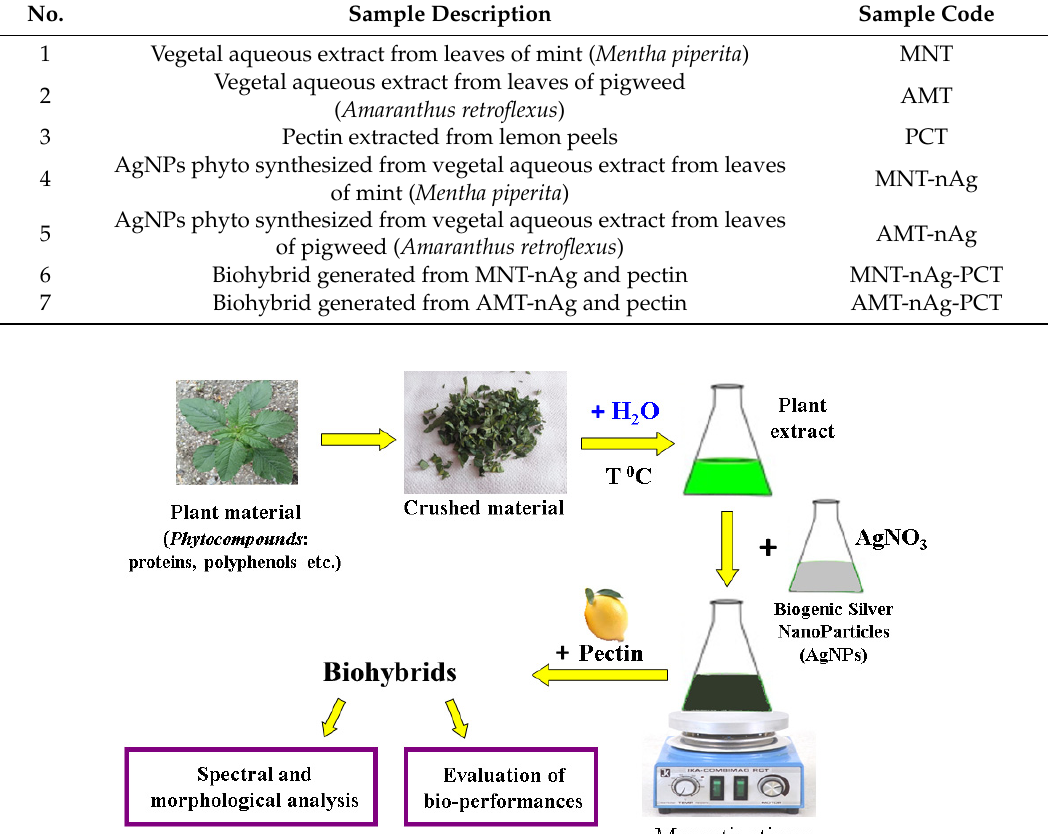
Figure 1. Schematic representation of phyto-generation of silver nanoparticles and preparation of pectin-coated bio-nanosilver.